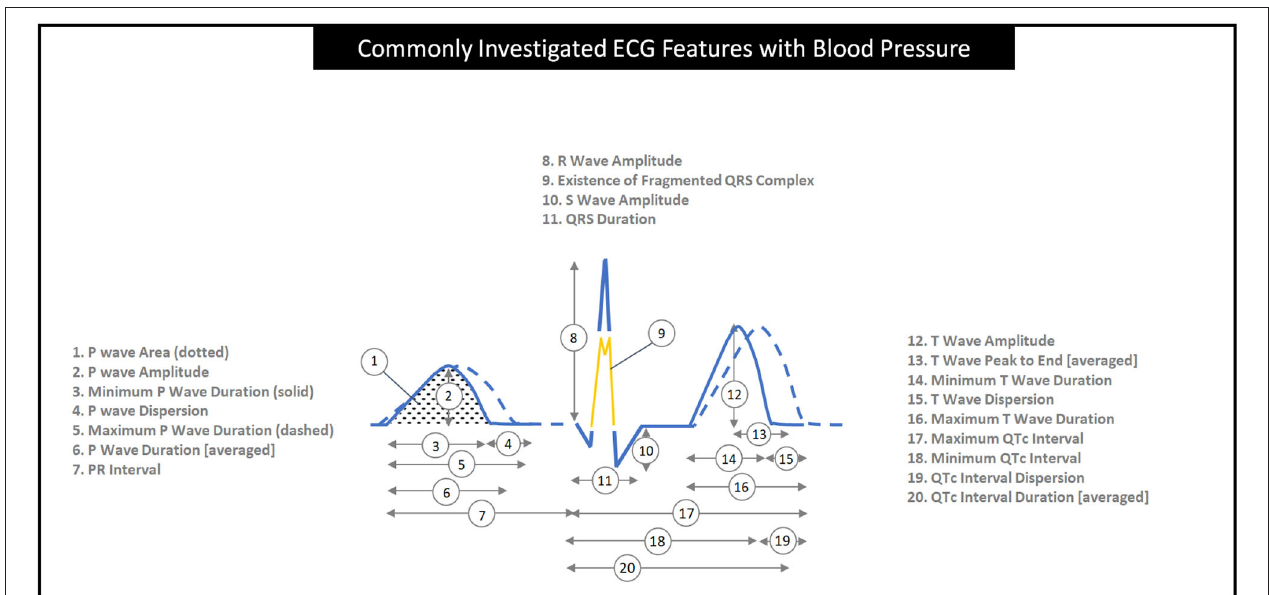
FIGURE 2 | The graphical definition of common ECG wave features seen in this review of 35 articles. QT intervals in numbers 8 to 11 are corrected for heart rate into QTc intervals by applying a formula such as Bazett’s (QTc signal segments (solid and dashed) are collected from the same